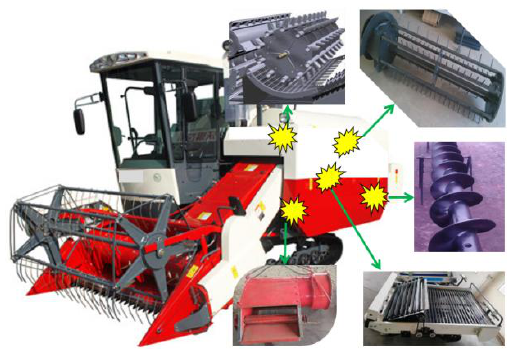
Figure 1. Combine harvester with multi-source excitation.